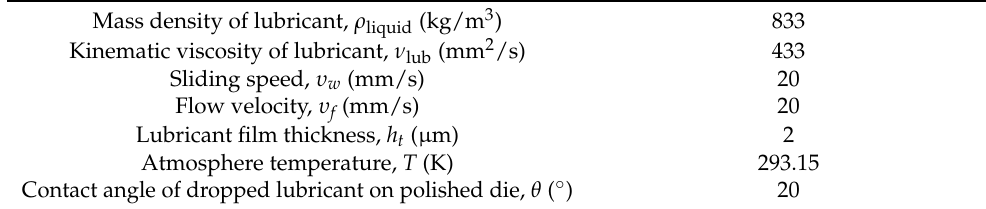
Table 3. Properties of fluids and analytical conditions for laminar one-phase flow analysis.